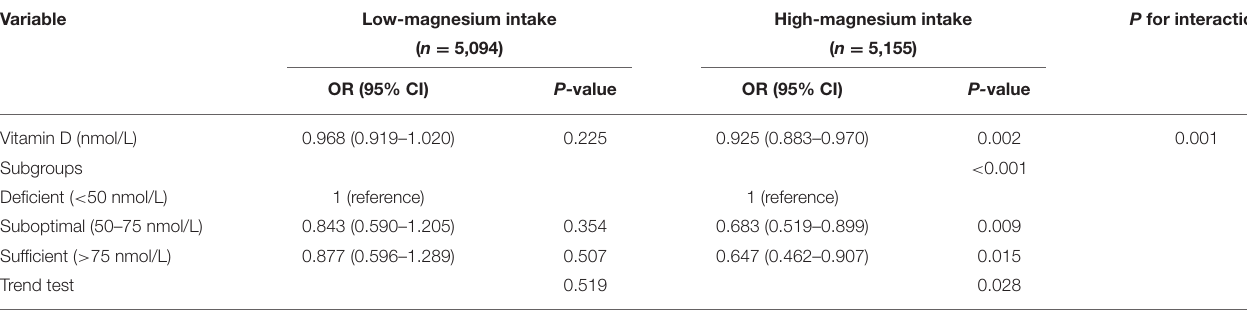
TABLE 3 | Interactive effect of vitamin D and dietary magnesium intake on T2D (All participants).